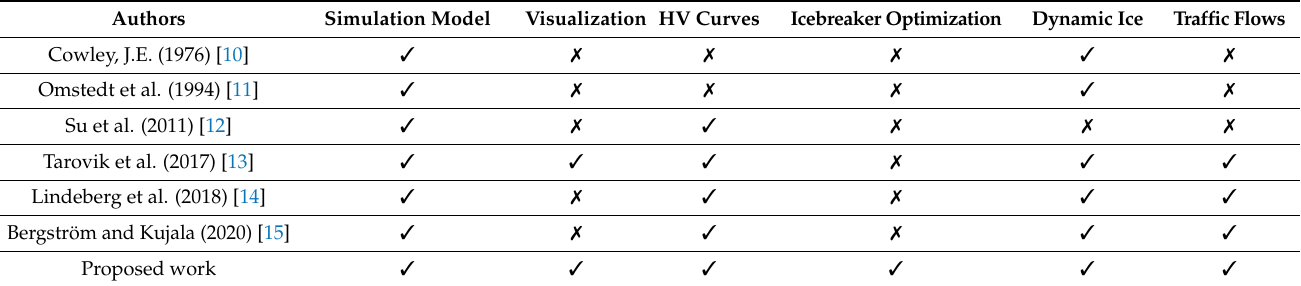
Table 1. Prior work in winter navigation